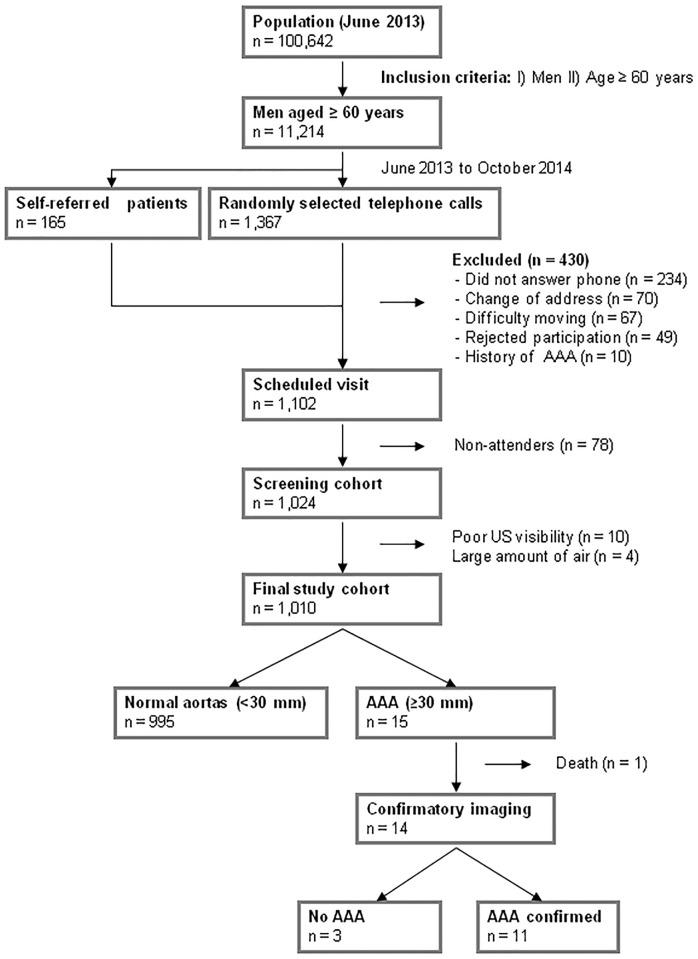
Screening flowchart.